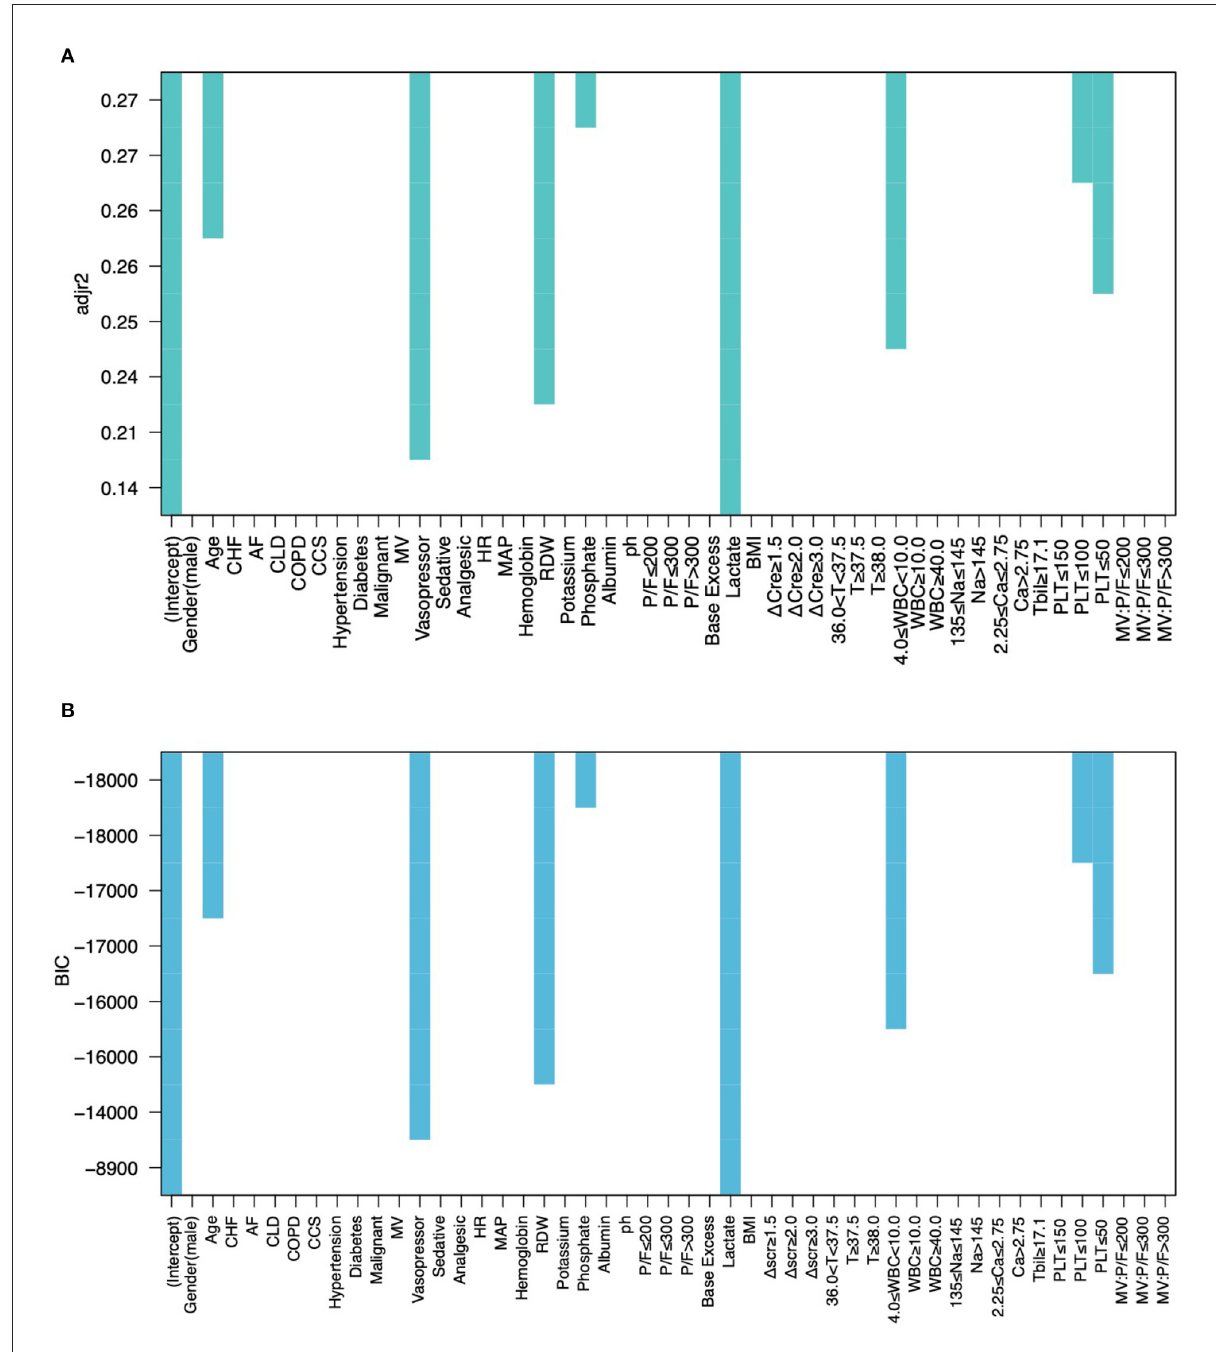
FIGURE2 All-subsets regression by adjusting the r-squared value (A) and BIC (B)